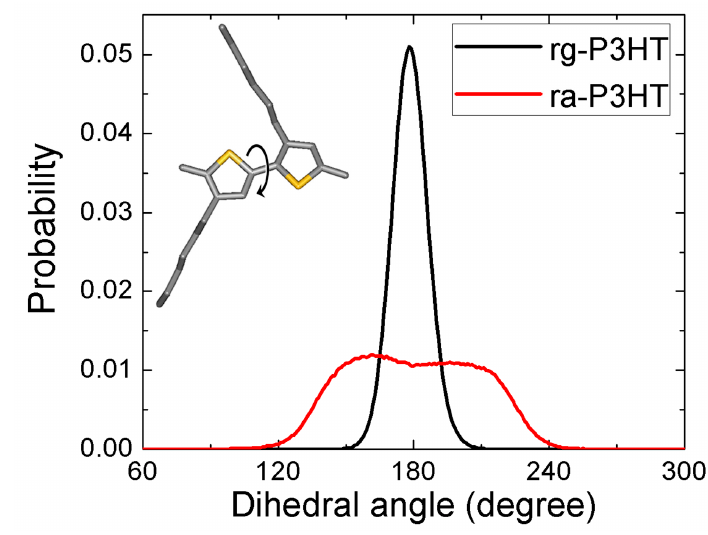
Figure 6. Statistical distribution of the dihedral angles between the neighboring thiophene rings in the simulated rg-P3HT and ra-P3HT chains. The dihedral angle is defined in the inset picture.